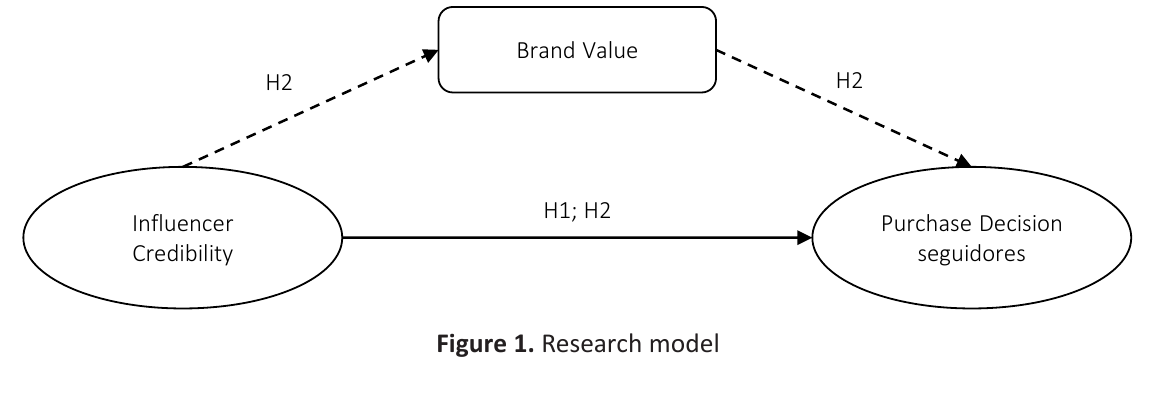
Figure 1. Research